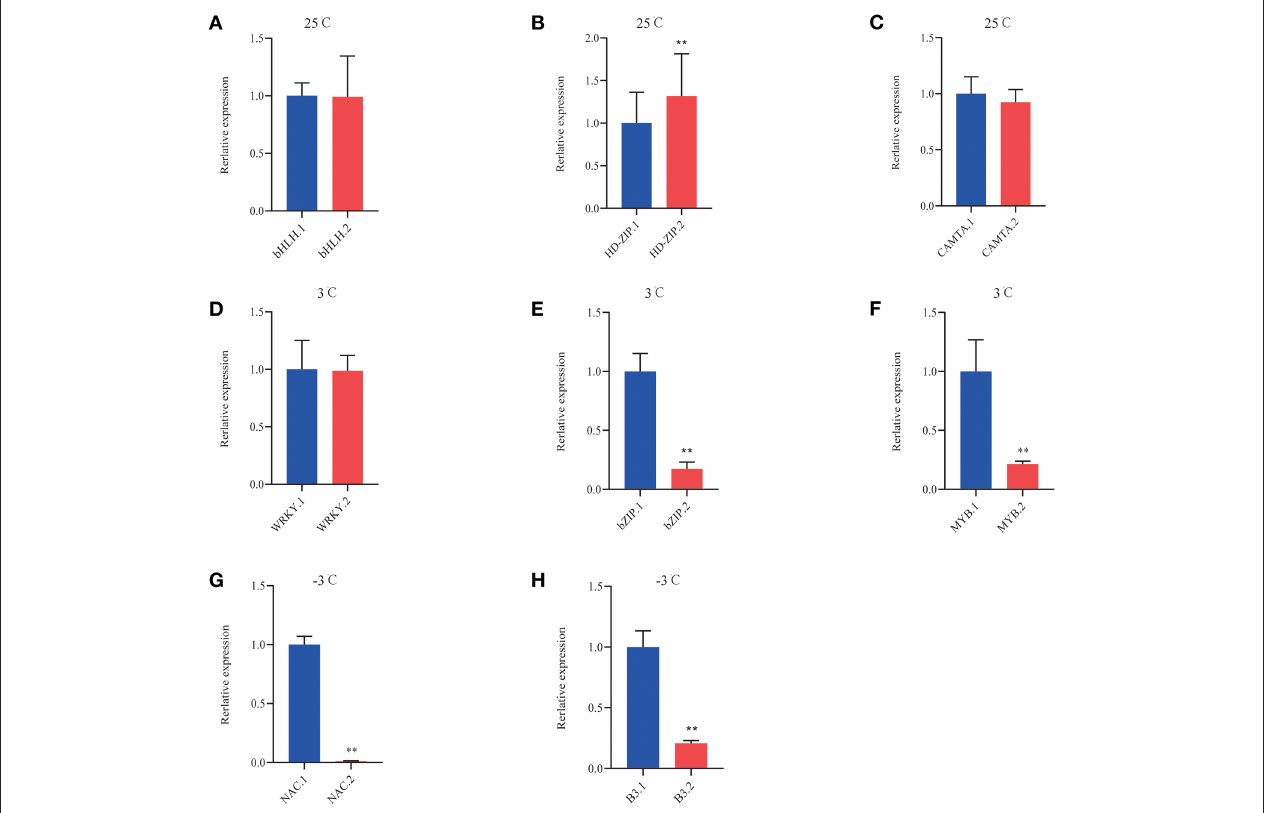
FIGURE 12 | QRT-PCR analysis of DAS isoforms of TFs in P. ussuriensis compared with P. trichocarpa . (A–C) DAS genes of TFs at 25 ◦ C. (D–F) DAS genes of TFs at 3 ◦ C. (G,H) DAS genes of TFs at − 3 ◦